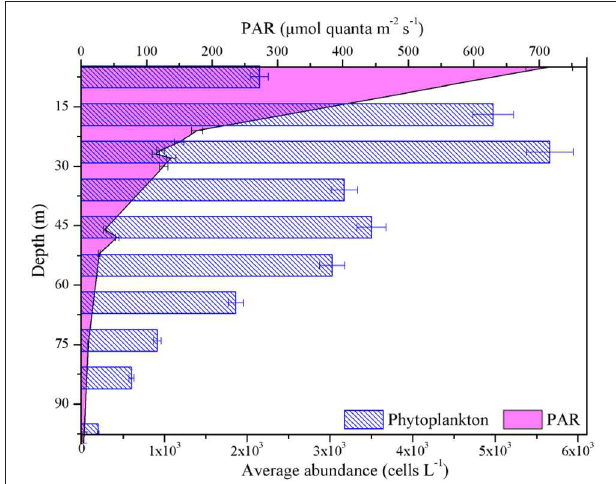
FIGURE 8 | Vertical profiles for average values of phytoplankton abundance and PAR in the BOB.